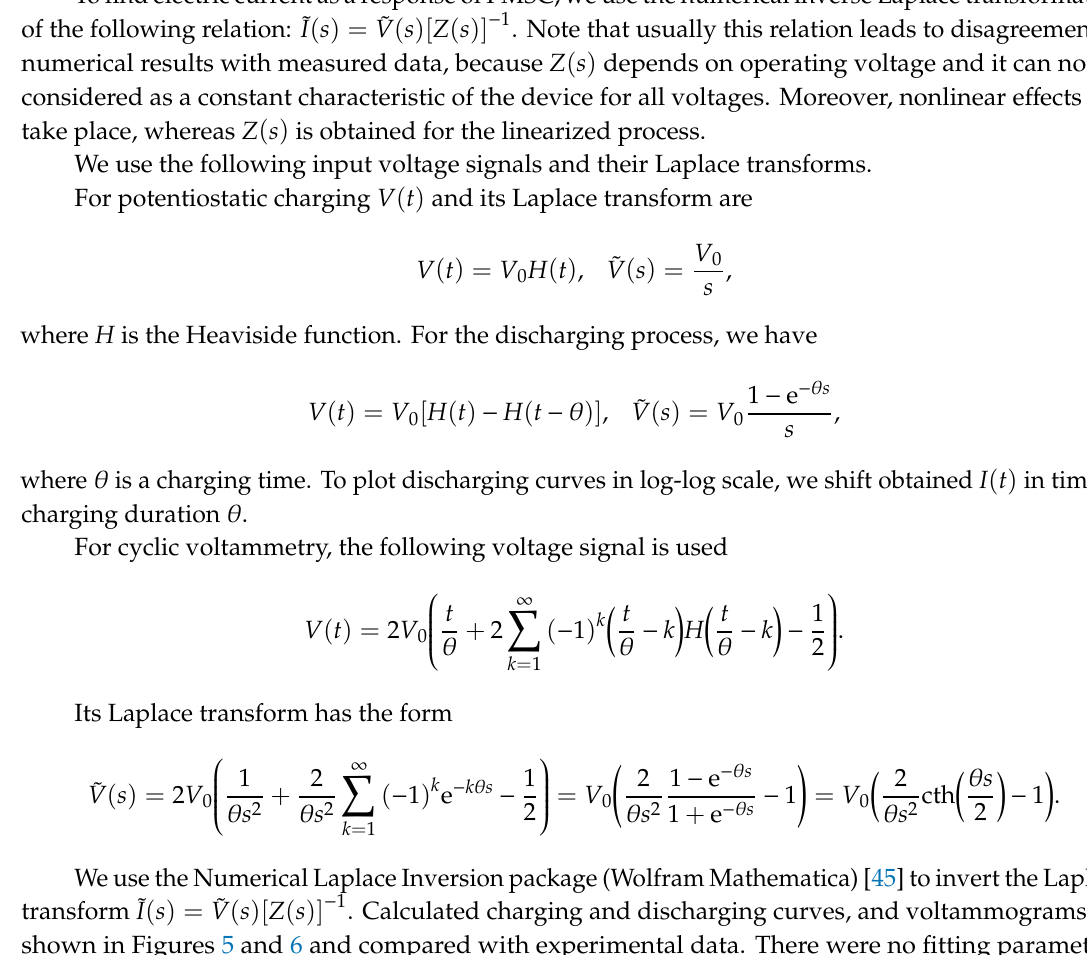
Figure 4. Nyquist plot ( a ) and frequency dependence of phase shift ( b ) for PMSC (D33) with PVA + LiCl electrolyte. Circles are experimental data, dots are the result of fitting by impedance Equation (8). To find electric current as a response of PMSC, we use the numerical inverse Laplace